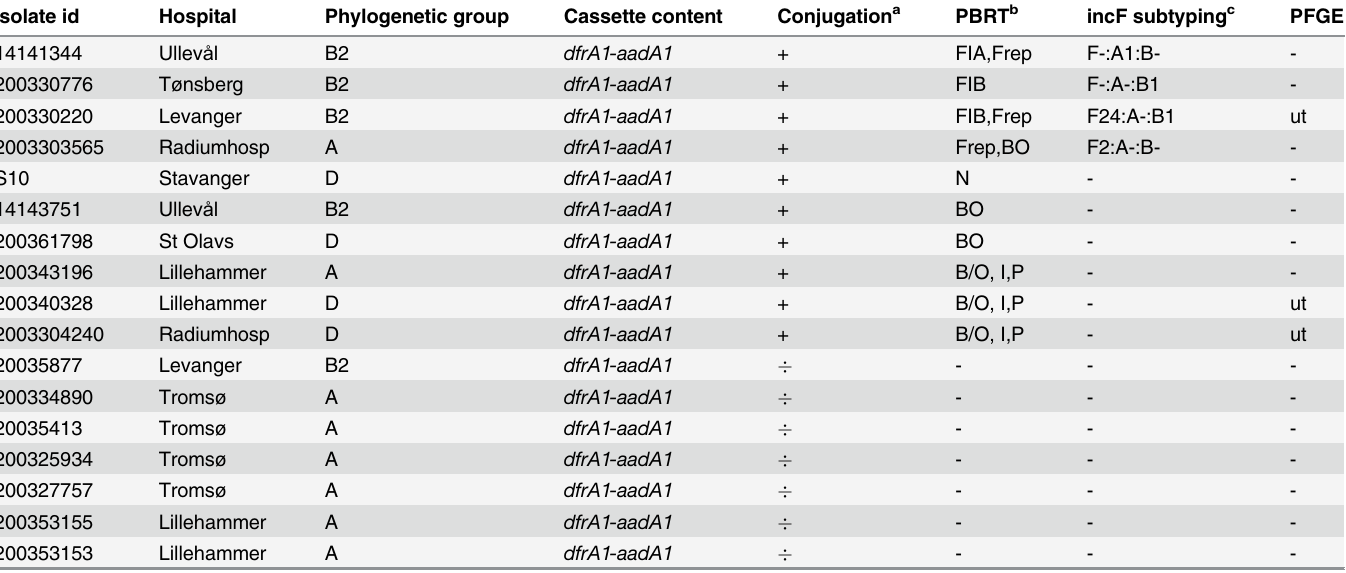
The isolates were recovered from humans with blood stream infections.